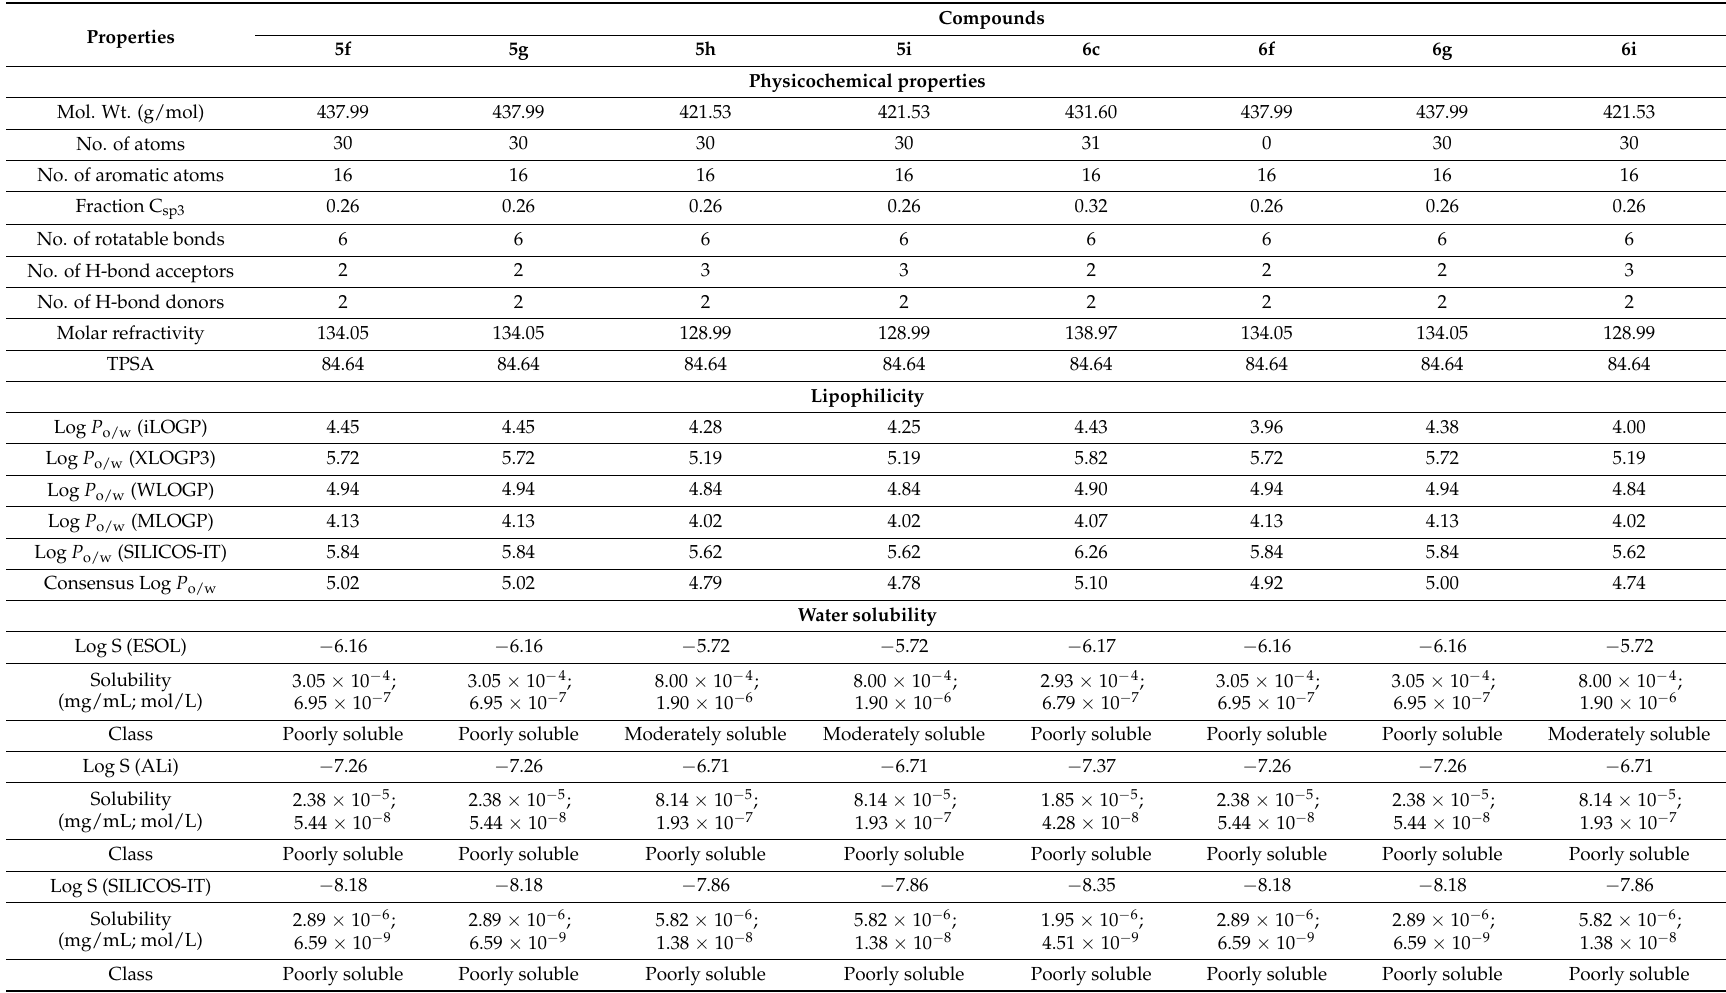
Table 3. ADMET prediction scores for the selected compounds